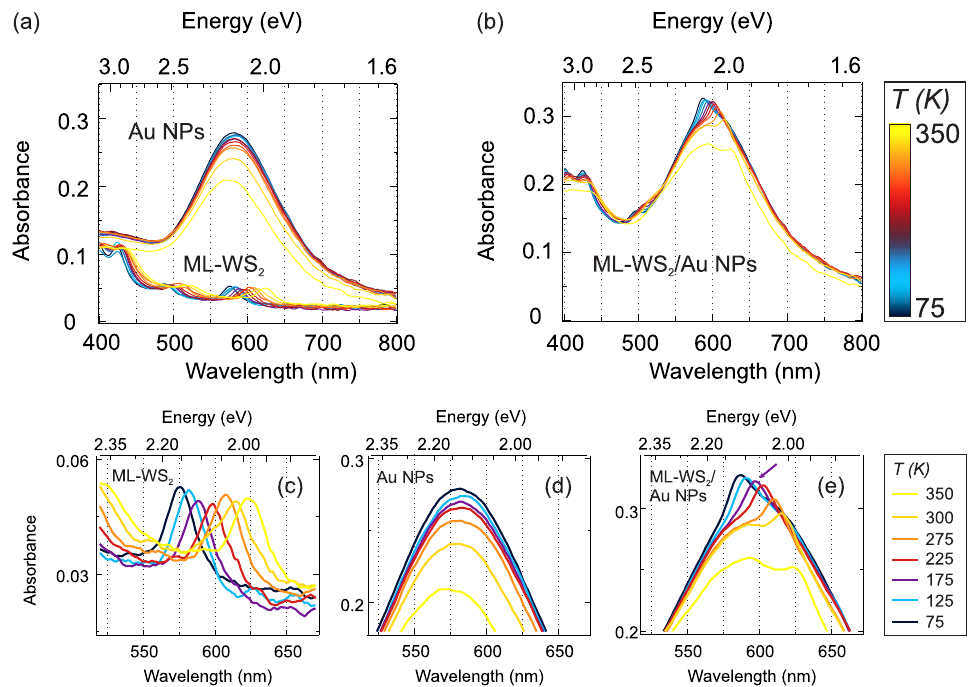
Figure 3. ( a ) Micro-absorbance spectra in the temperature range 75–350 K (from black to yellow) of the two sub-systems, Au NPs/LiF and WS 2 /LiF. ( b ) Micro-absorbance spectra in the temperature range 75–350 K (from black to yellow) of the WS 2 /Au NPs/LiF heterostructure. Zoom in the spectral region of ( c ) A exciton of ML-WS 2 /LiF, ( d ) the maximum of the LSPR peak of Au NPs/LiF and ( e ) the maximum in the absorbance spectra of the hybrid system, WS 2 /Au